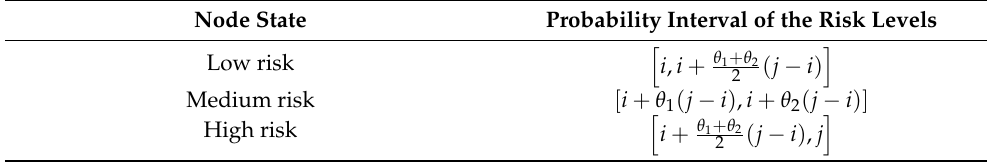
Table 1. Node state and its corresponding probability interval based on fuzzy trigonometric